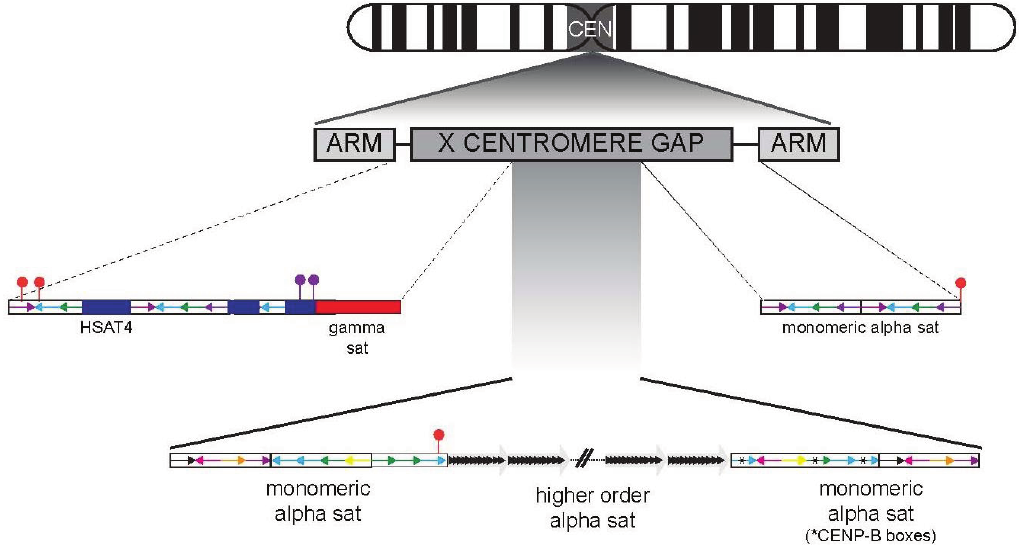
Figure 4. The detailed genomic organization of the human X centromere. The first contiguous genomic map of a human centromere (CEN) on the X chromosome was completed in 2001 and showed that the higher order array (large light gray arrays containing black monomer arrowheads) is flanked by unordered, monomeric alpha satellite DNA (multi-colored arrows). The regions between monomeric alpha satellite and the chromosome short (Xp) and long (Xq) arms contain other types of satellite DNA, such as gamma satellite and HSAT4. LINEs (red lollipops) and SINEs (purple lollipops) punctuate the repetitive DNA between the centromere and chromosome arms. The Xq pericentromere contains monomeric alpha satellite and a LINE element at the pericentromere-arm junction. Some of the monomers within the unordered Xq satellite contain CENP-B boxes (black asterisks). The functional significance of these monomers remains